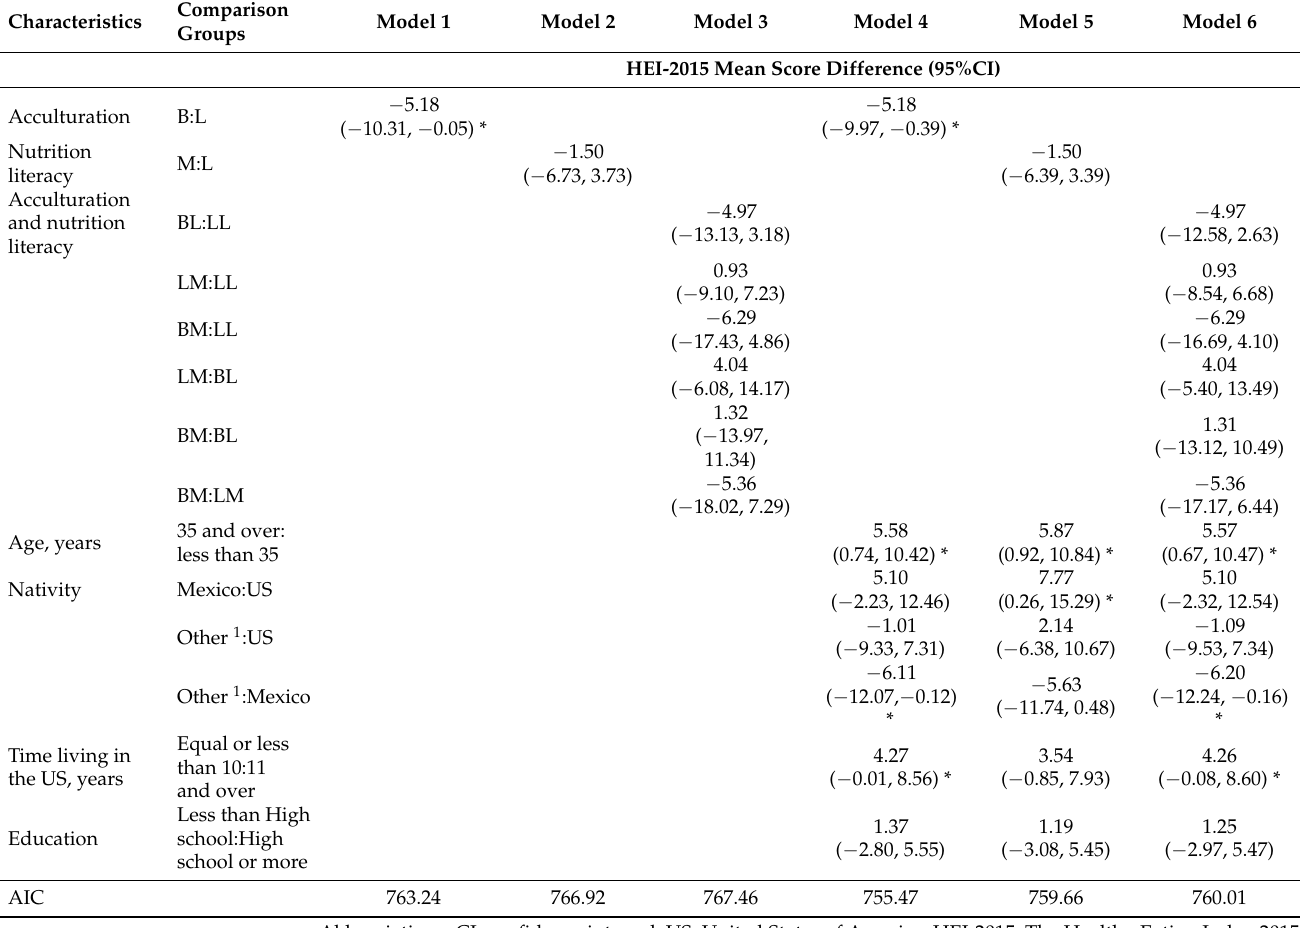
Table 2. Average diet quality score differences by Analysis of Variance (ANOVA) tested